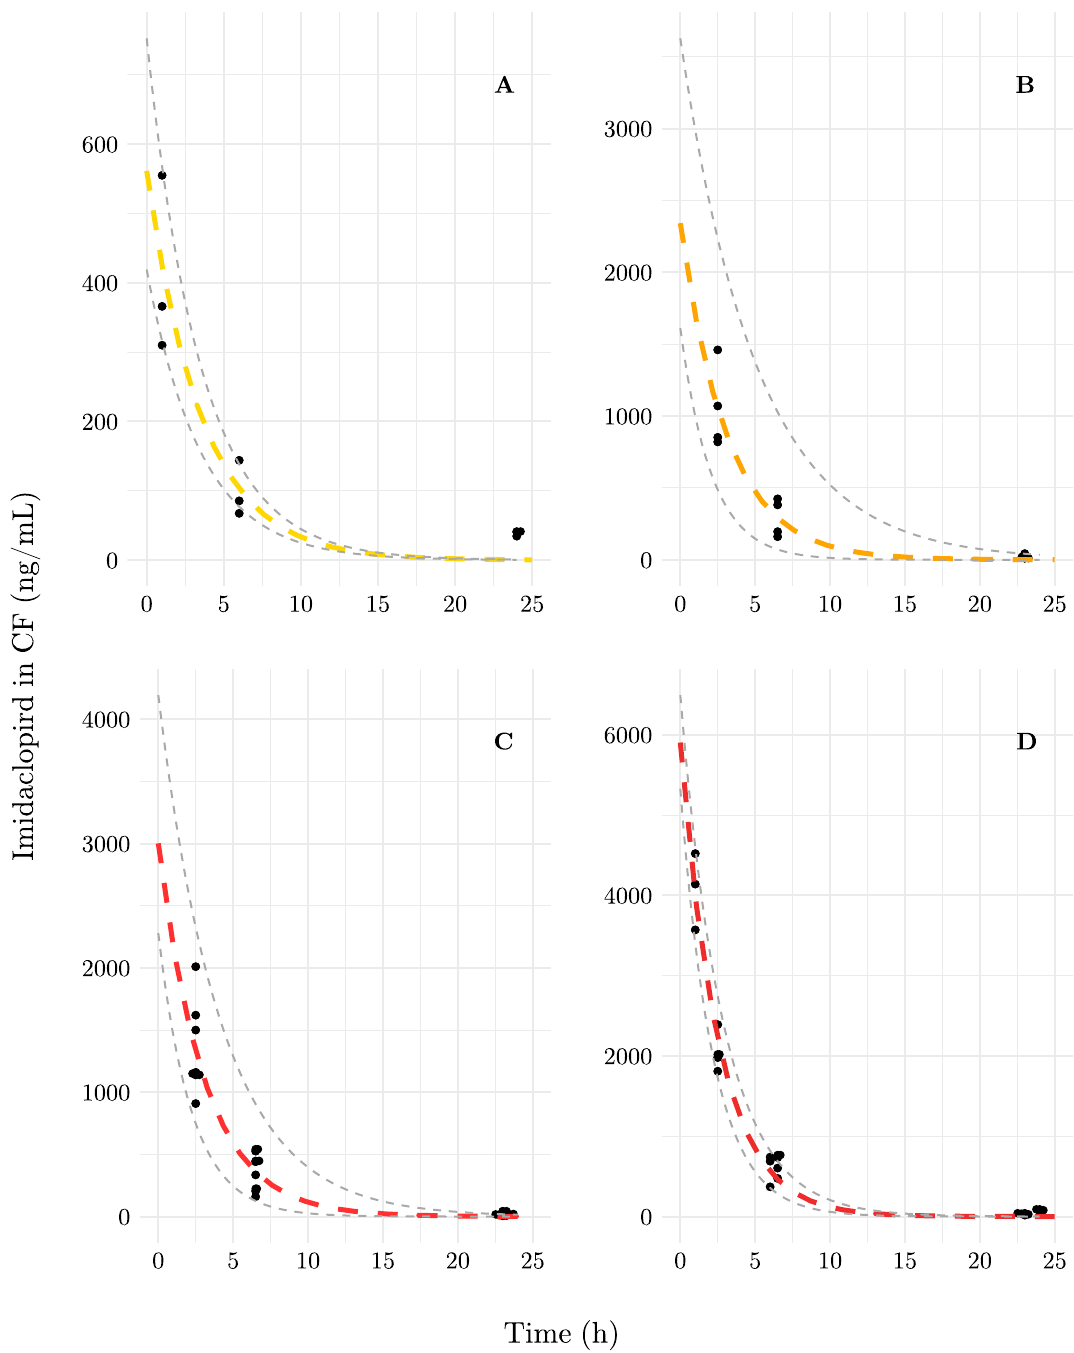
Figure 2. Excretion model of imidacloprid in the cloacal fluid of ruby-throated hummingbrids exposed to ( A ) 0.2 µ g g − 1 · Body Weight (BW); ( B ) 1.0 µ g g − 1 · BW; ( C ) 2.0 µ g g − 1 · BW; or ( D ) 2.5 µ g g − 1 · BW. Convergence on parameter estimates was achieved by nonlinear least-squares regression. 95 % confidence intervals for excretion models described by Eq. (3) were determined by bootstrap resampling 45 . Parameter estimates and confidence intervals are listed in Table 1. Samples were pooled by time point across dosing days by individual. Summary statistics of analytical chemistry results are reported in Table